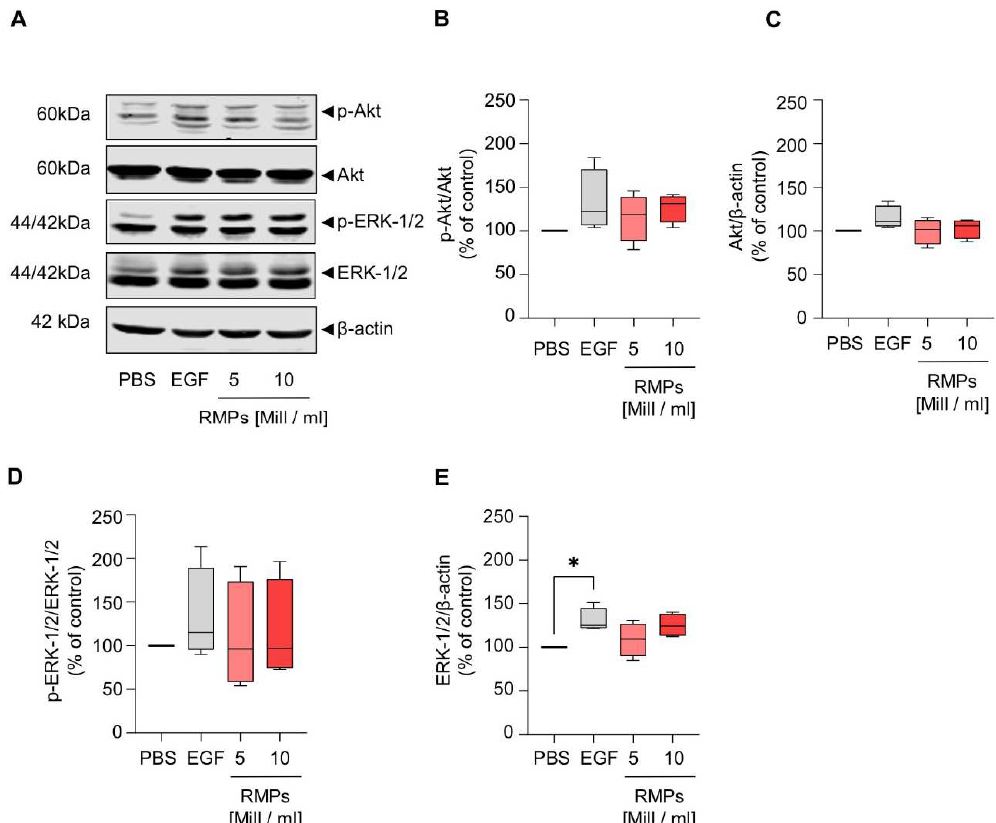
Figure 6. Influence of red-blood cell-derived microparticles on Akt and ERK signaling in HCT-116 cells. HCT-116 cells were incubated with two concentrations of RMPs (5 × 106 or 10 × 106 particles/mL), vehicle control (PBS) and EGF (50 ng/mL) as positive control. After 24 h (RMP and PBS treatment) or 30 min (EGF treatment), whole cell lysates were prepared and the protein levels of p-Akt, Akt, pERK-1/2 and ERK were assessed by Western blot analysis. β-actin was used as loading control. ( A ) One representative Western blot is shown out of four independent experiments ( n = 4) ( B – E ) Quantification of p-Akt ( B ), Akt ( C ), p-ERK-1/2 ( D ) and ERK-1/2 ( E ) levels after normalization to either loading control ( C , E ), Akt ( B ) or ERK-1/2 ( D ). Data represents median, 25th to 75th percentile (box), minimum to maximum (whiskers) versus vehicle control ( n = 4). Statistical control (* p ≤